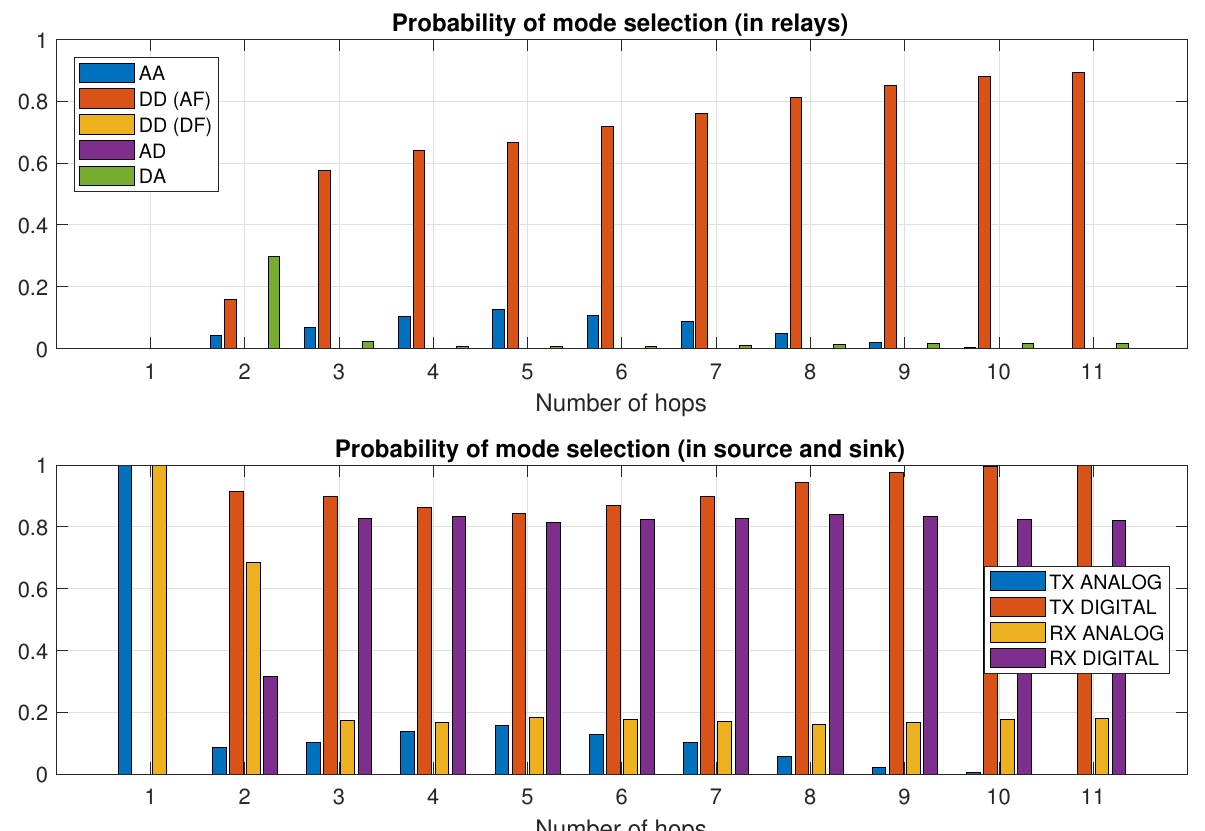
Figure 4. Probability of transmission mode selection (area width of 3